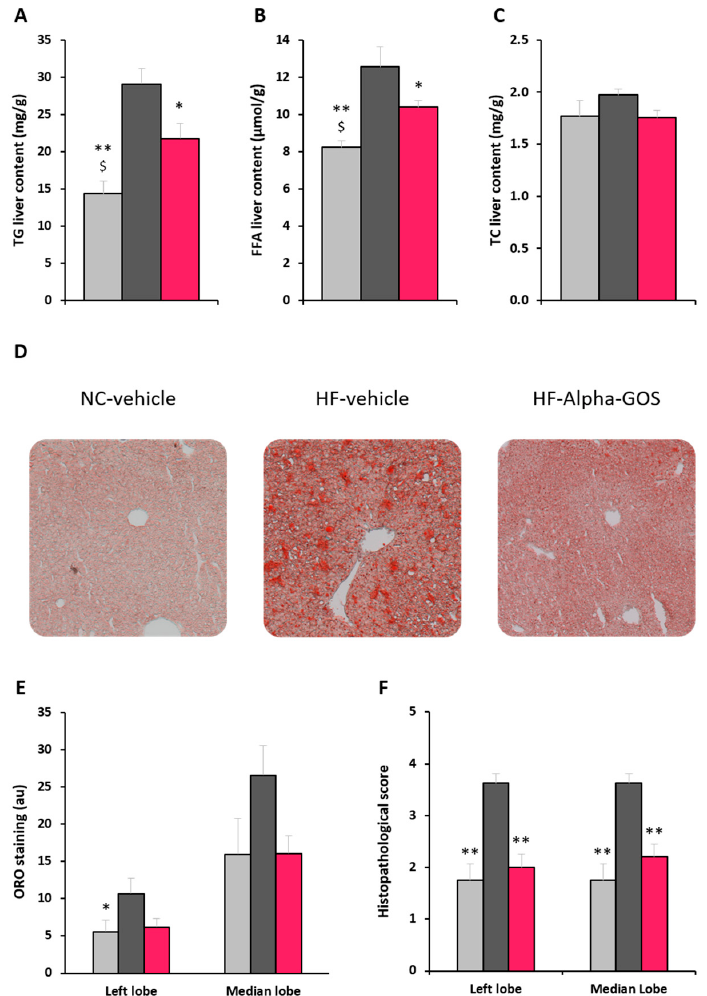
Figure 3. Effect of α -GOS on liver parameters during the treatment phase. ( A ) Hepatic triglycerides content. ( B ) Hepatic free fatty acids content. ( C ) Hepatic total cholesterol content. ( D ) Representative photographs of Oil-Red-O staining of the left liver lobe. ( E ) Oil-Red-O staining values ( F ) Histopathological scores for Oil-Red-O staining of liver sections. Data are mean ± standard error of the mean (SEM). NC, light gray bars, n = 8; HFD-control, dark grey bars, n = 10; HFD- α -GOS, pink bars, n = 10. * p < 0.05 and ** p < 0.001 vs. HFD-control group; $ p < 0.05 for NC vs. HFD- α -GOS.